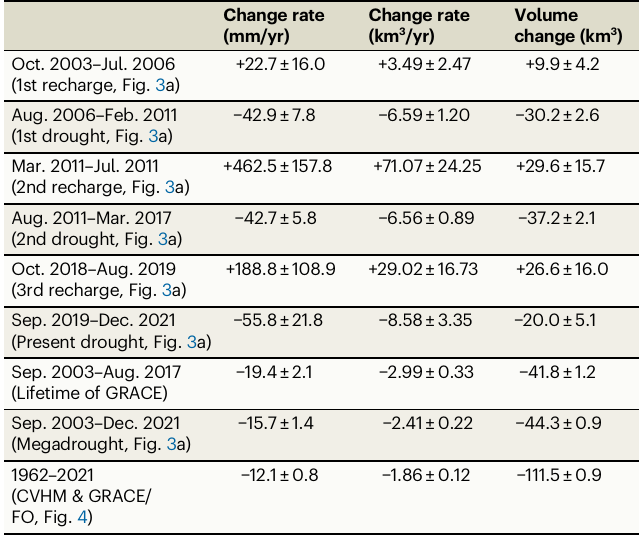
Table 1 | Groundwater change rates and total groundwater volume changes in the Central